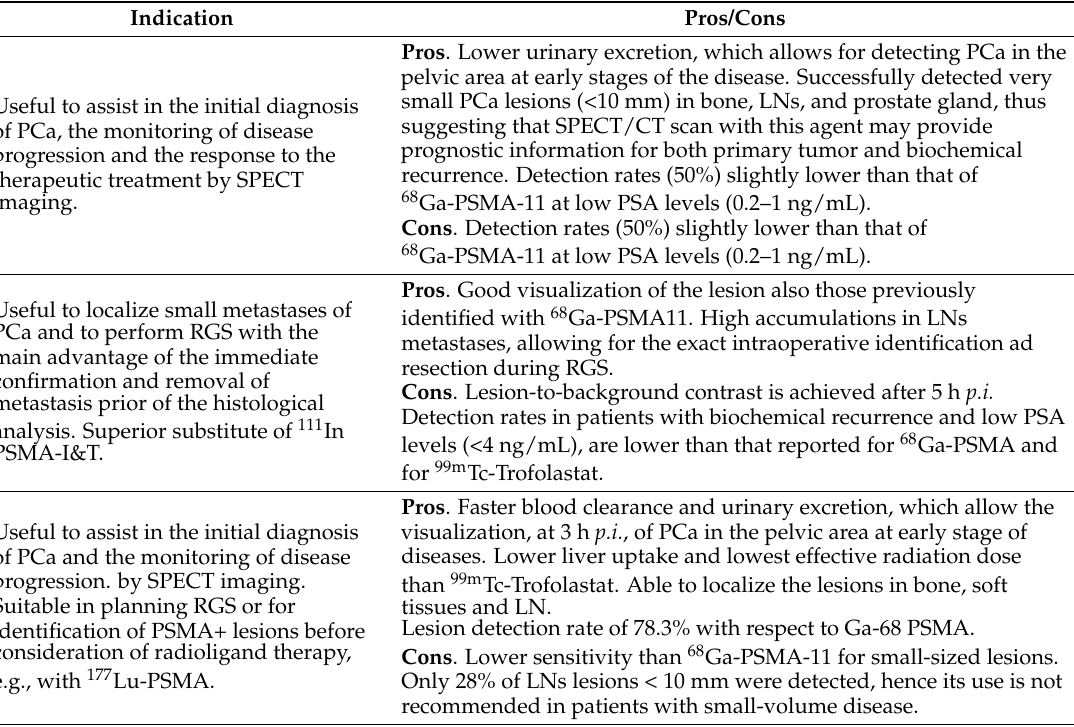
Table 7. Formulation, indication, advantages and disadvantages of [ 99m Tc]Tc-PSMA RPs under clinical